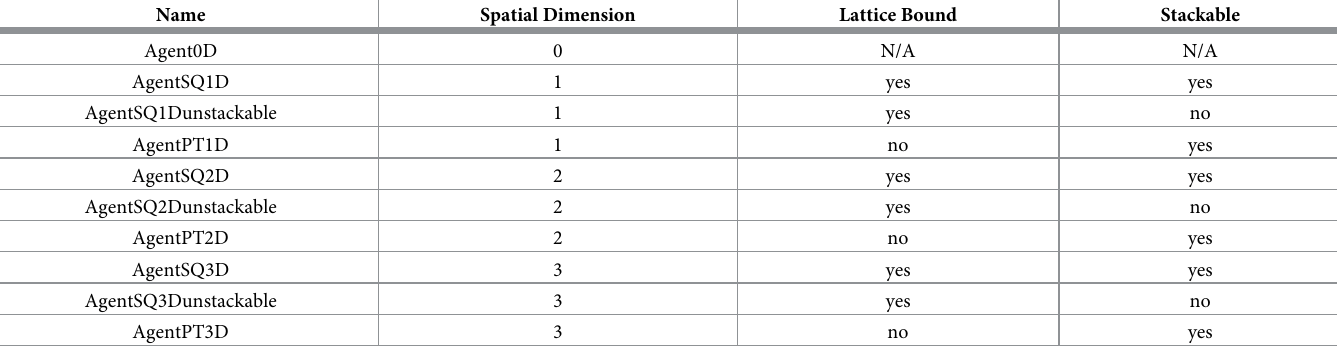
Table 2. The 10 base agent types in HAL. The differences between them are displayed in each column. Stackable refers to whether multiple agents can exist on the same lattice position. The complete type heirarchy used in HAL is described in Fig D in S1 Text.